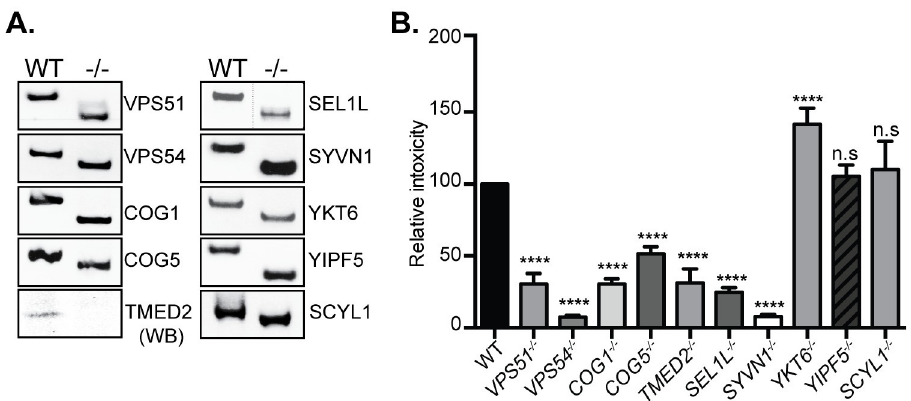
Fig 3. Validation of candidate genes involved in typhoid toxin intoxication. (A) Genotyping of the CRISPR/ Cas9-generated knockout cells. Genomic DNA was purified from CRISPR-Cas9 edited HEK293T cell lines and analyzed by PCR with specific primers listed in S3 Table. The TMED2-deficient cell line was examined by Western blot with an anti TEMED2-specific antibody. Dotted lines indicate places where the experimentally relevant lanes were spliced together (all lanes originate from a single gel). (B) Relative toxicity of typhoid toxin in the indicated knockout cell lines after treatment with a serial dilution of purified toxin. The relative toxicity was determined from the percentage of cells at the G 2 M phase fitted by nonlinear regression as indicated in the Materials and Methods. Values, which were normalized relative to wild type (considered 100) are the mean ± SEM of independent determinations. ���� p < 0.0001; n. s.: differences not statistically significant; two-tailed Student’s